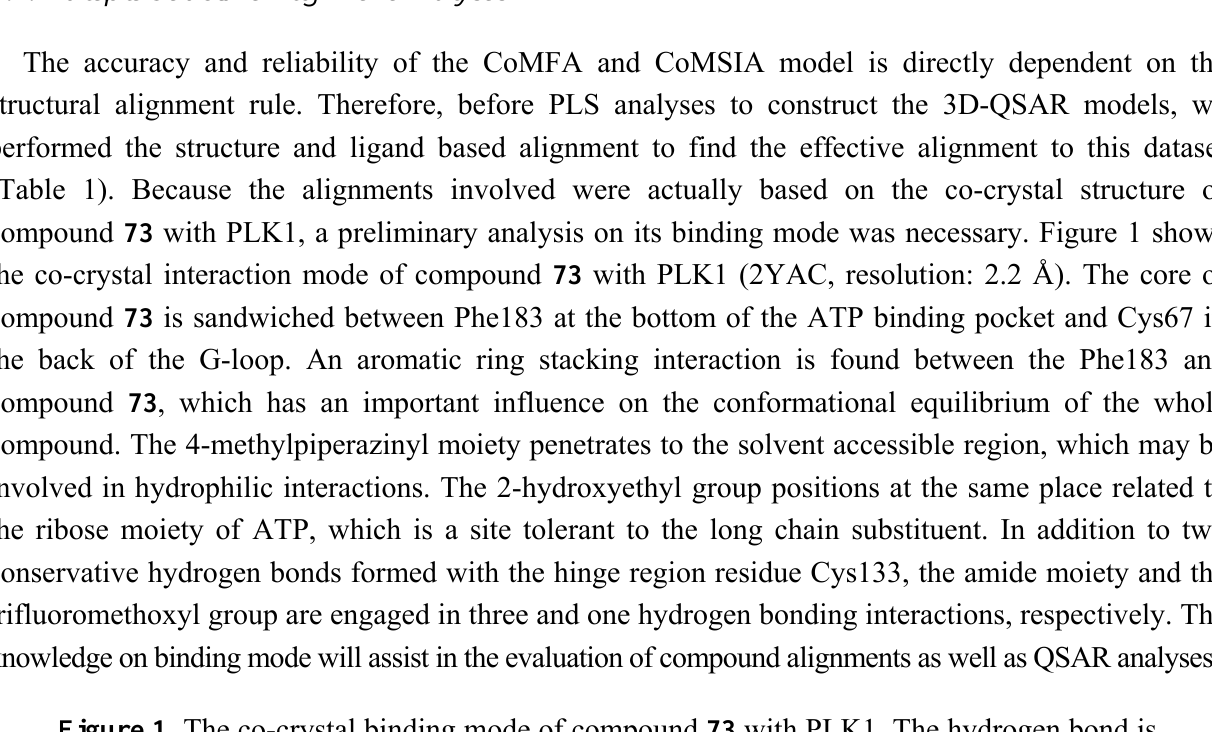
Figure 1. The co-crystal binding mode of compound 73 with PLK1. The hydrogen bond is represented with red dotted